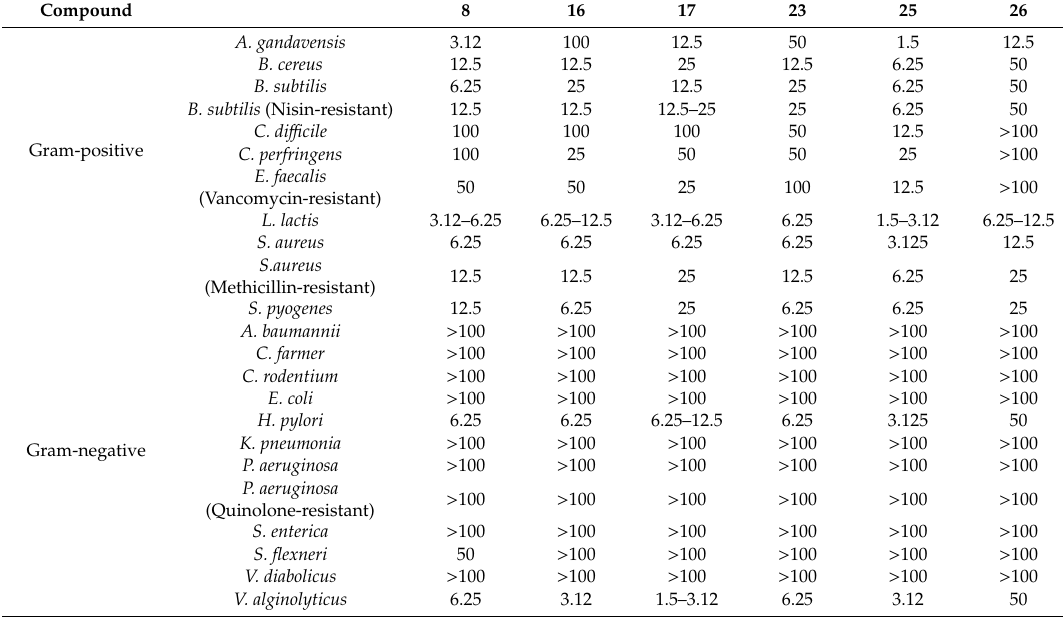
Table 4. Evaluation of the spectrum of antimicrobial activity of the most active berberine derivatives. Antibacterial and antifungal activities of the most active berberine derivatives identified in Table 1 were further tested using a large panel of microbial strains as explained in the Materials and Methods section. Values in the table correspond to Minimal Inhibitory Concentration (MIC) expressed in µ M. Compound 8